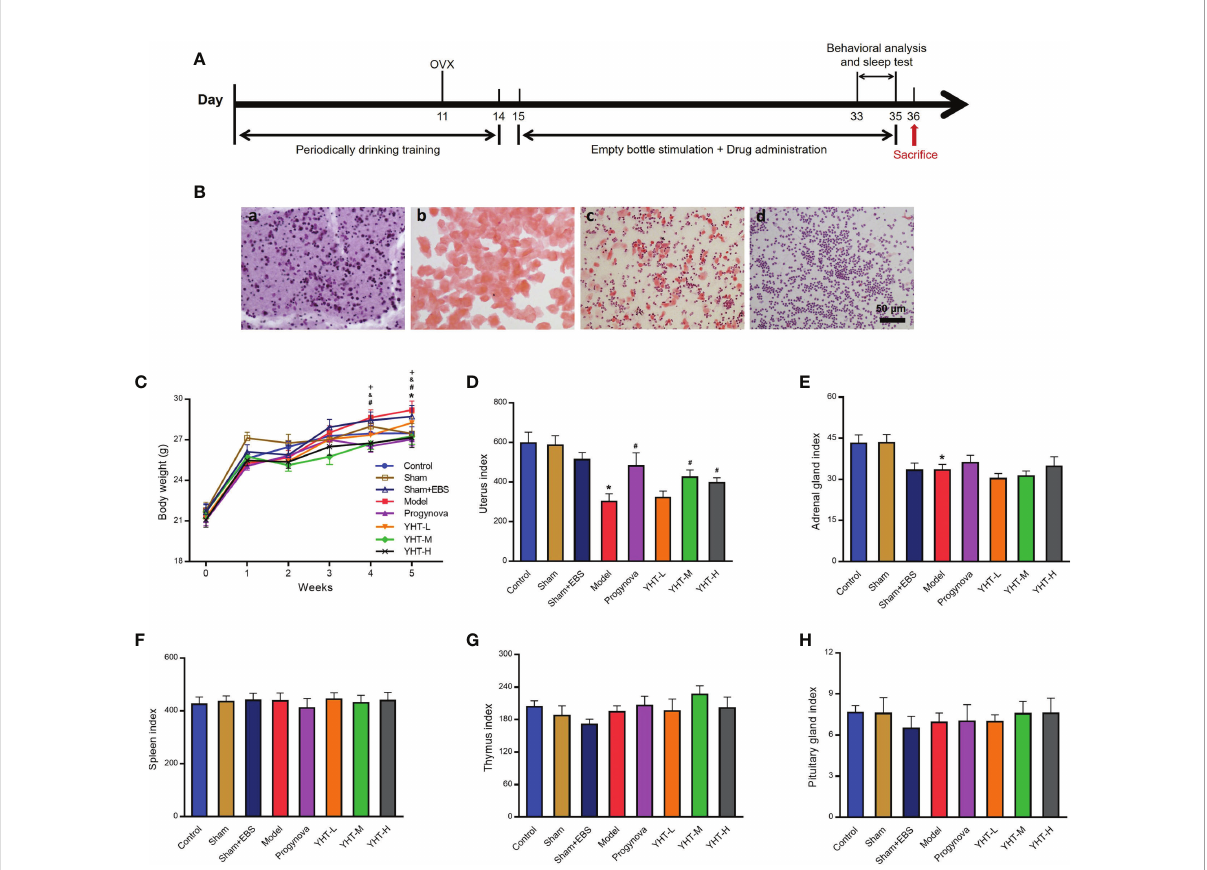
FIGURE 2 Effects of YHT on the body weight and organ index in menopausal mice. (A) Experimental manipulation of mice during the study. (B) H&E staining of vaginal smears from mice in the four different phases of the estrous cycle. a) Proestrus. b) Estrus. c) Metestrus. d) Diestrus. (C) Body weight of mice in 5 weeks. *p < 0.05, control group vs model group; #p < 0.05 progynova group vs model group; &p < 0.05 YHT-M group vs model group; + p < 0.05 YHT-H group vs model group. (D – H) Organ index of the uterus, adrenal gland, spleen, thymus, and pituitary. *p < 0.05 vs control group; #p < 0.05 vs model group. EBS, empty bottle